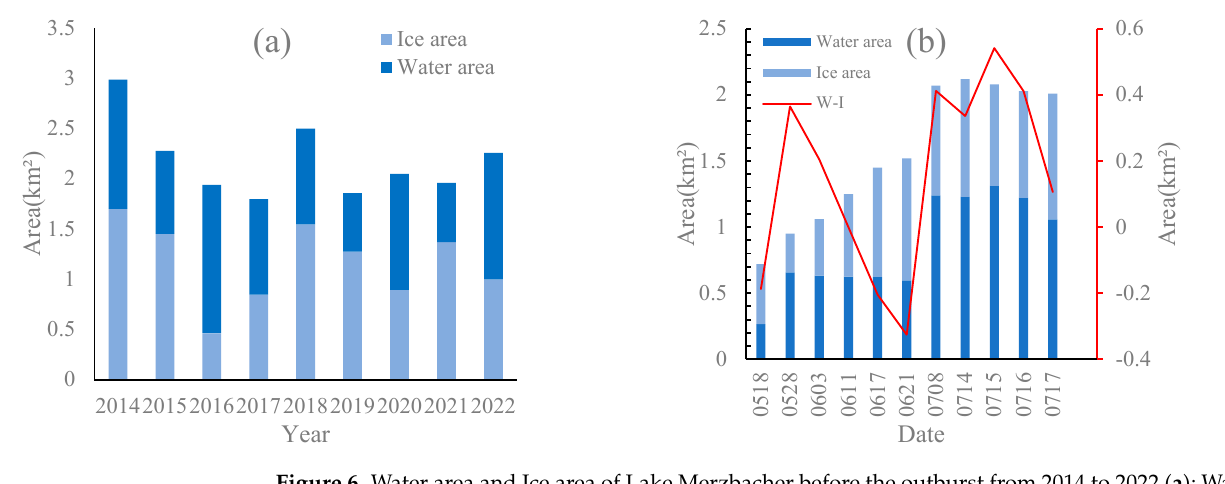
Figure 6. Water area and Ice area of Lake Merzbacher before the outburst from 2014 to 2022 ( a ); Water area and Ice area daily changes before the outburst ( b ).